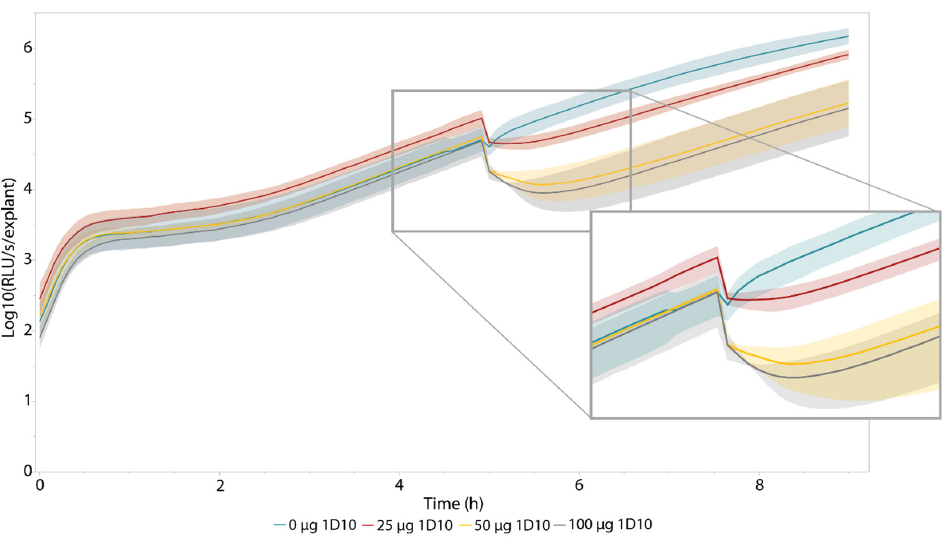
Figure 4. Longitudinal bioluminescence intensity measurements of antibacterial treatment effect with 1D10 on A. baumannii NCTC13423:: luxCDABE growth in the pig skin burn wound model. At t = 5 h, the explants were treated with either 0, 25, 50, or 100 µ g 1D10 (n = 3). Immediately after treatment with 1D10, the measured luminescence drops due to instant cell lysis inherent to the mode-of-action of engineered lysins [28]. This is visualized in the enlarged panel of the figure. The error bands indicate one standard deviation from the mean. Table 1. Characterization of the antibacterial effect of the engineered lysin 1D10 . The minimum values upon antibacterial treatment were determined together with the time required to obtain these minima. The final columns display the calculated area under the curve for the treatments in the first four hours after treatment, the time frame of interest upon administration of this fast- acting enzybiotic. The values represent the average of three biological replicates (n = 3) and the standard deviation. Both the drop in bioluminescence intensity and the areas under the curves corresponding to the antibacterial effect were compared with the control using a two-tailed Student’s t -test. For the comparison of the time needed to reach the relative minimum bioluminescence intensity measurement, a one-sided t -test was performed. These data are graphically illustrated in Figure